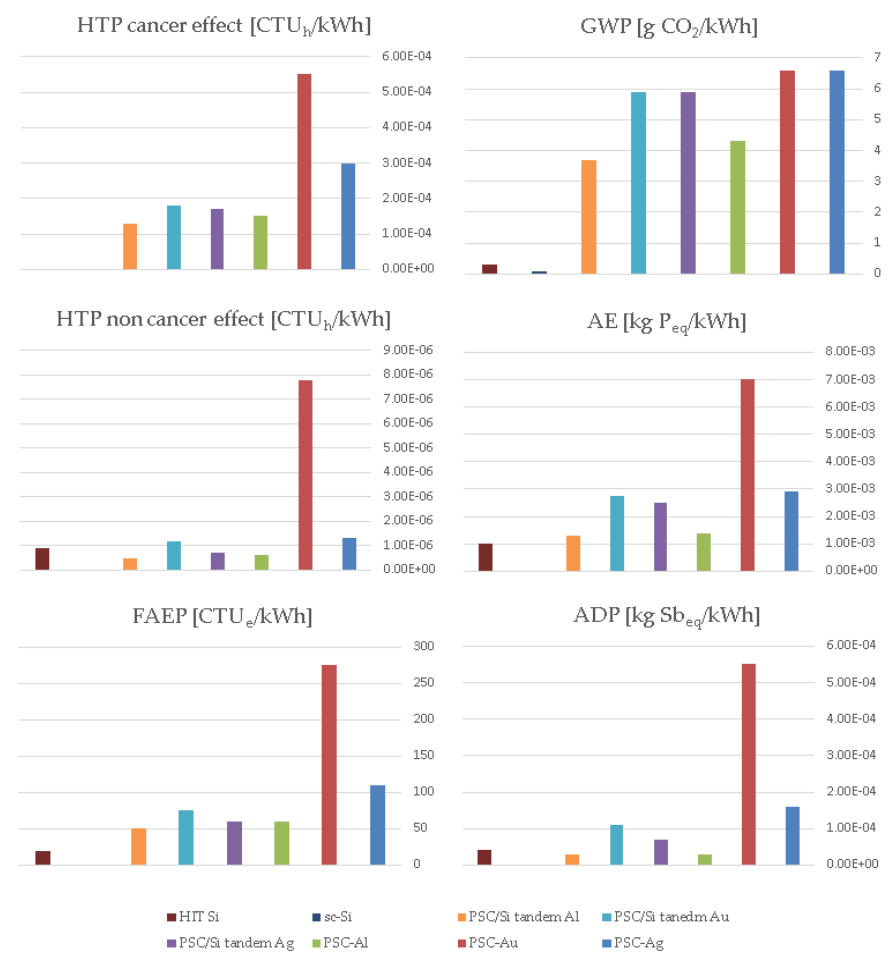
Figure 2. Environmental impacts of different solar cells [66].